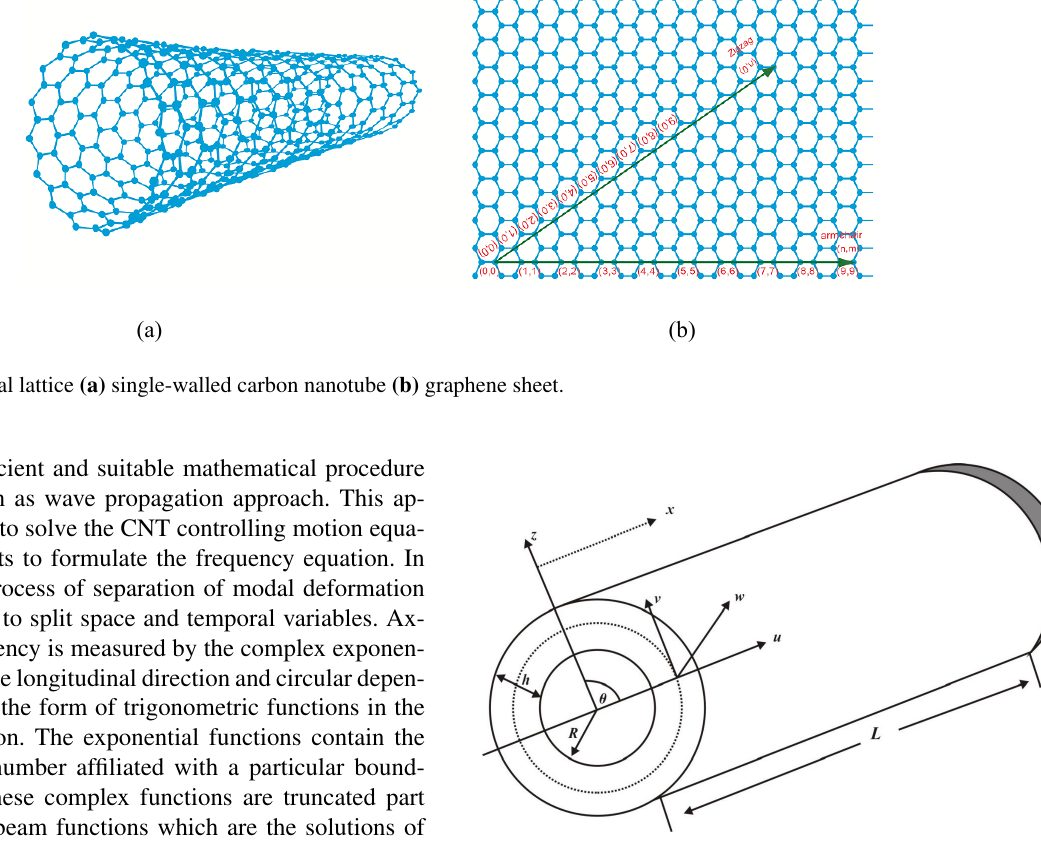
Figure 2. Geometry of